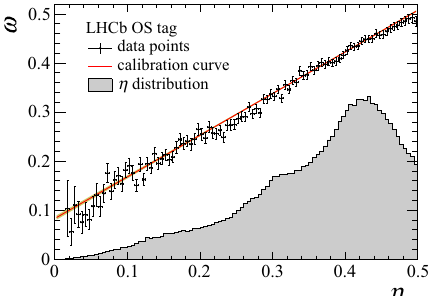
Fig. 7 Calibration of the OS tagger using B + → J /ψ K + decays. The black points show the average measured mistag probability, ω , in bins of predicted mistag, η , the red line shows the calibration as described in the text and the yellow area the calibration uncertainty within one standard deviation. The shaded histogram shows the distribution, with arbitrary normalisation, of η in the background subtracted B 0 s → J /ψ φ sample, summing over candidates tagged as B 0 s or B 0